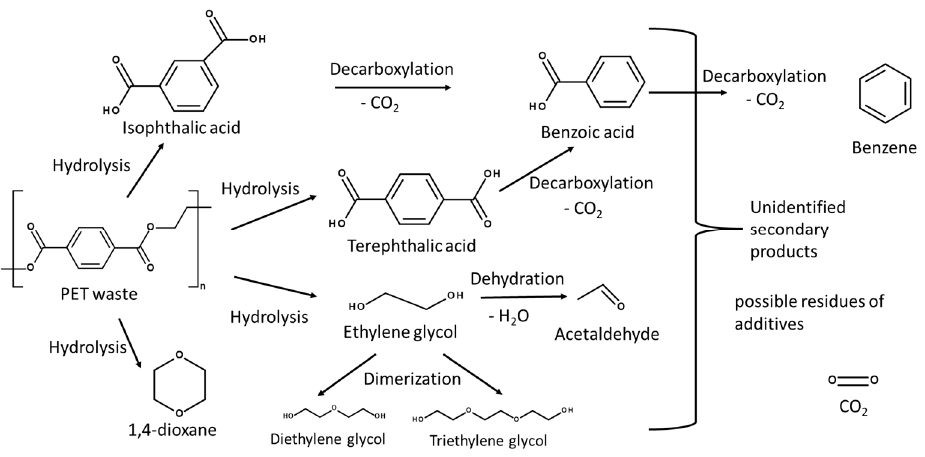
Figure 2. Reaction pathway of PET waste in SubCW.